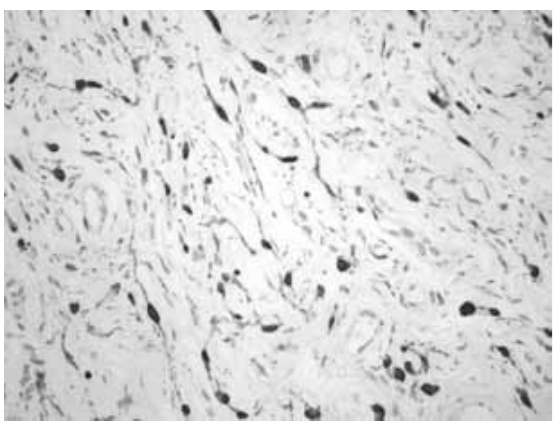
figurE 1 – Positive immunohistochemical expression of S-100 protein in neurofibromas (LSAB 400×) LSAB: labeled streptavidin-biotin